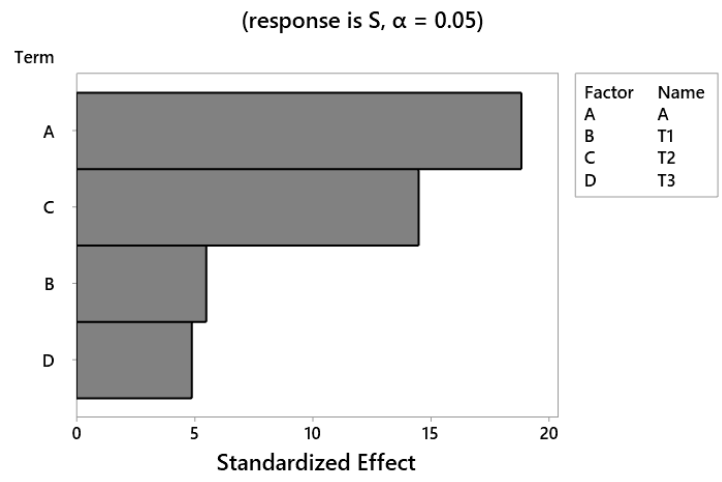
Figure 10. Pareto chart of the standardized effects.